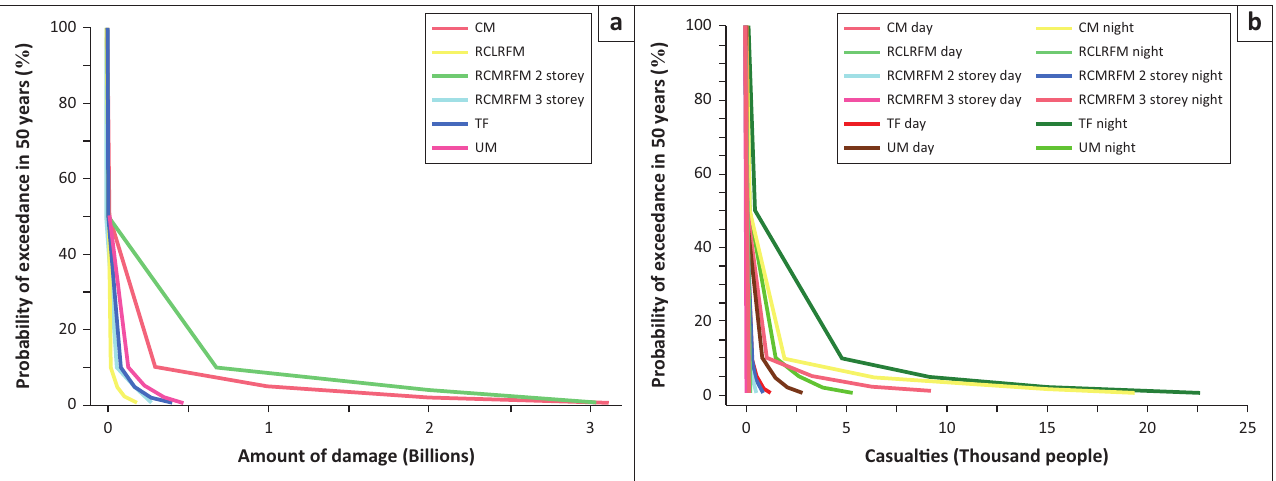
FIGURE 7: Established that risk curves for each building type in terms of (a) economic loss and (b)